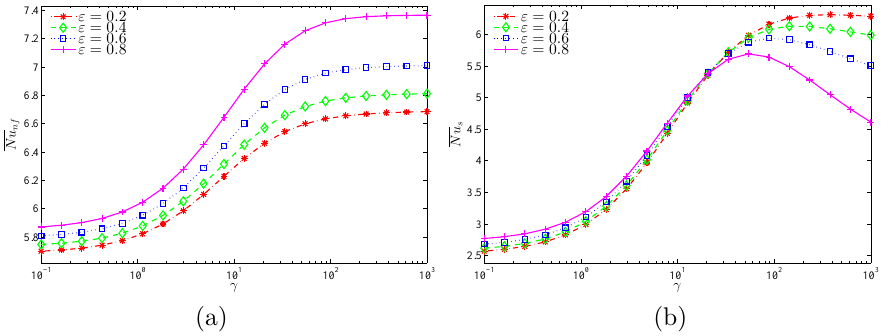
Figure 18. Variations of ( a ) the average Nusselt number of the nanofluid phase and ( b ) the average Nusselt number of the solid phase with γ for different ε values at Da = 10 − 3 , φ = 0.02, and A =